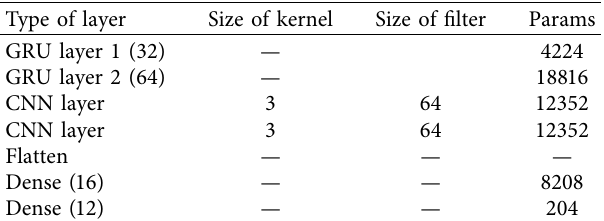
Figure 2: Visual representation of the (a) recurrent neural network, while (b) represents the gated recurrent Table 1: Detailed summary of the proposed model for short-term one-hour ahead solar power forecasting model.